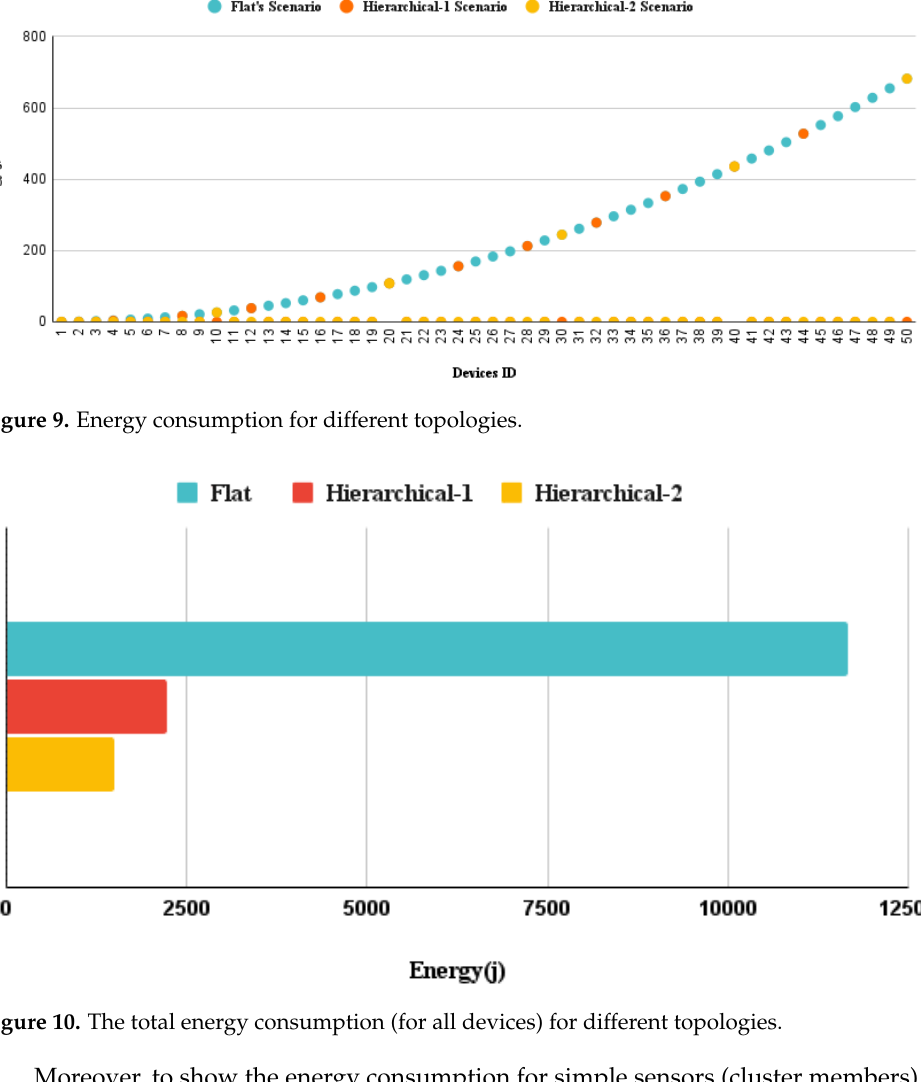
Figure 11. Energy consumption for simple sensors in different topologies. To have an effective network for different requirements, in terms of applications that we need to run across the pipeline, we must optimize the traffic generated and energy consumed, considering parameters such as measurement type and rate, sensor ranges and coverage, capacity limit, and the required density for each type of sensor. In this paper, we determined the parameters of the model such as throughput, energy consumption, number of sensors, and the inner distance between sensors to show how the parameters selection affect the model performance. As an example, we noticed that setting the size of the packet to the maximum size (255 bytes) resulted in the estimated energy consumption of around 1800 joule within a day for pressure sensors (when the inner distance is 200 m). We also determined the possible values and limitations of the